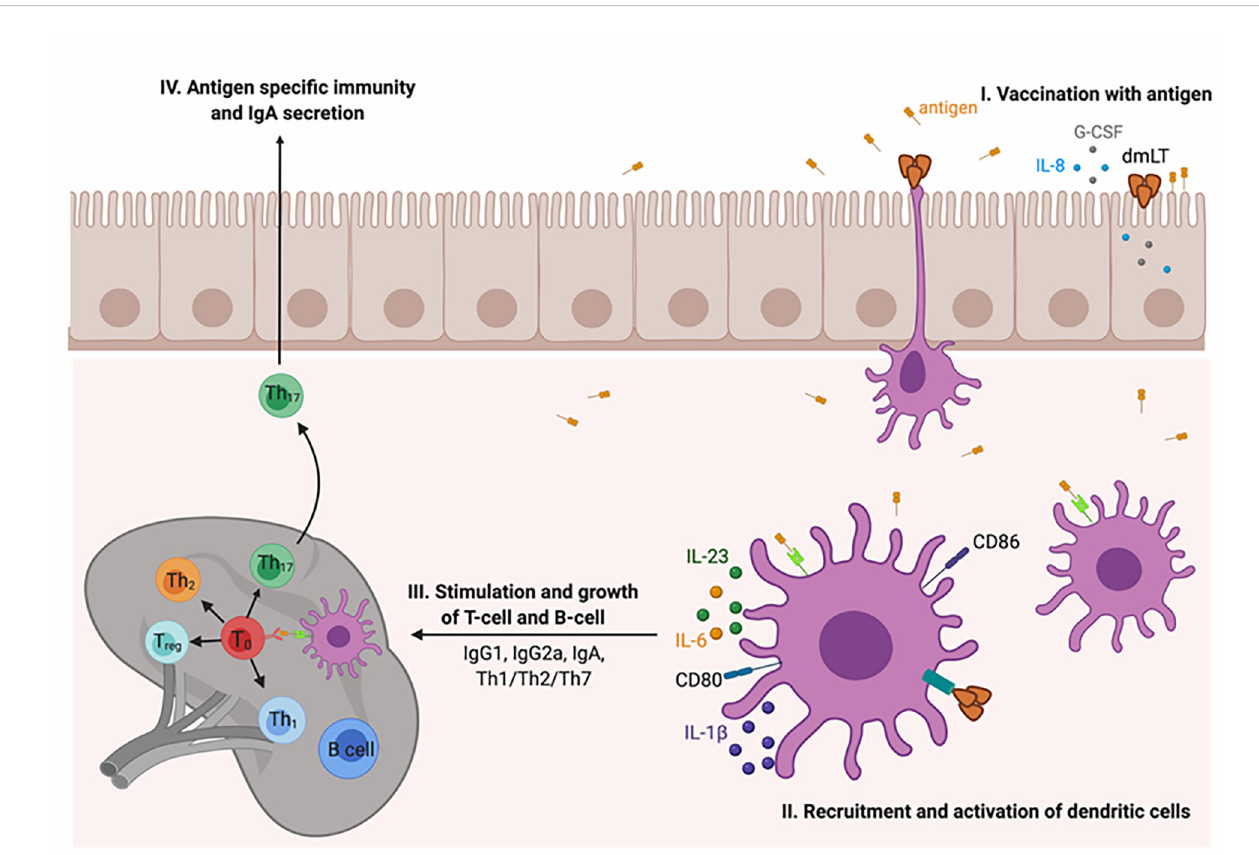
FIGURE 3 Mechanism of action of the dmLT adjuvant. (I) At the vaccination site, the dmLT adjuvant stimulates the innate immune response and activated epithelial cells secrete IL-8 and G-CSF. (II) Dendritic cells (DCs) are activated and recruited at the injection site where they process and present the antigen. It also upregulates the costimulatory molecules, i.e., CD80 and CD86, and stimulates the expression of IL-1, IL-6, IL-23, and G-CSF. (III) The activated DCs migrate to secondary lymphoid organs where they stimulate the differentiation of antibody-secreting plasma B cells and the generation of antigen- speci fi c Th cells. Overall, a strong Th17 immune response is imparted. Th17 cells are identi fi ed as essential in immunity and in stimulating germinal center formation in secondary lymphoid organs as well as in enhancing IgA